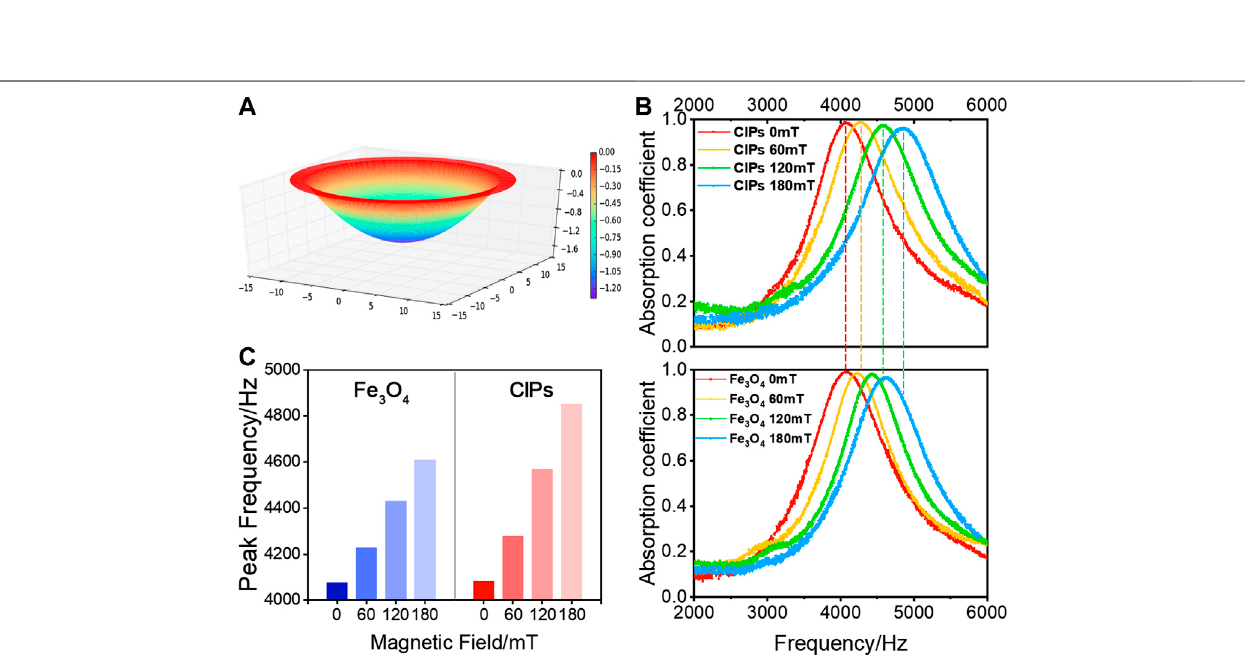
is applied on the 50 wt% CIP-MRM. The numerical analysis carried out by the fi nite element method con fi rmed that the off-plane displacement was positively related to the CIPs mass fractions and the magnetic fi eld strength. Then, the in fl uence